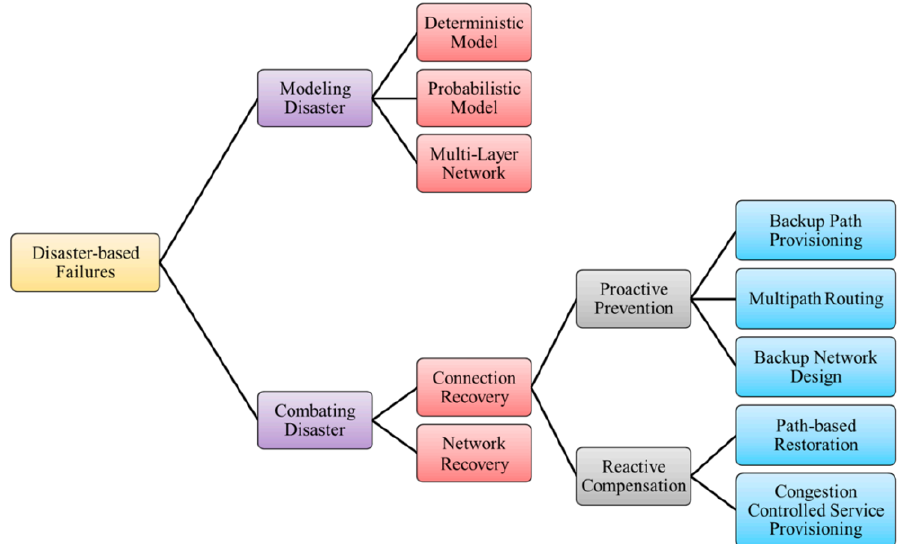
Figure 1. Overview of Disaster-based Failure Survivability Mechanisms [12].